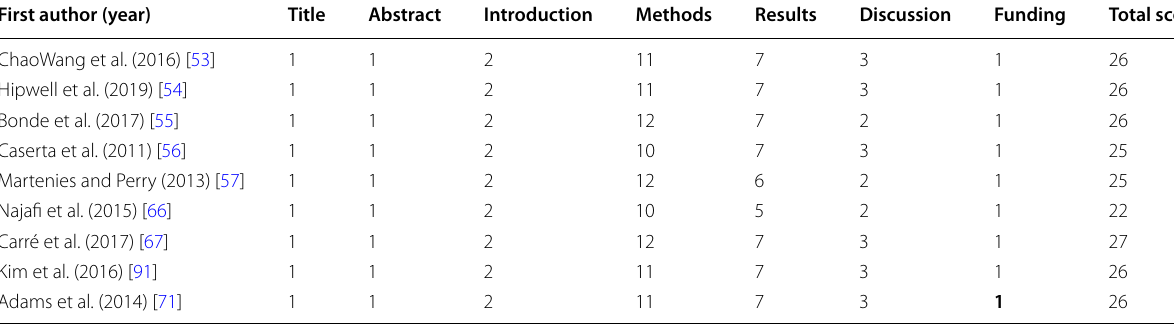
Table 5 Quality assessment of systematic review and meta-analysis studies (AMSTAR checklist)